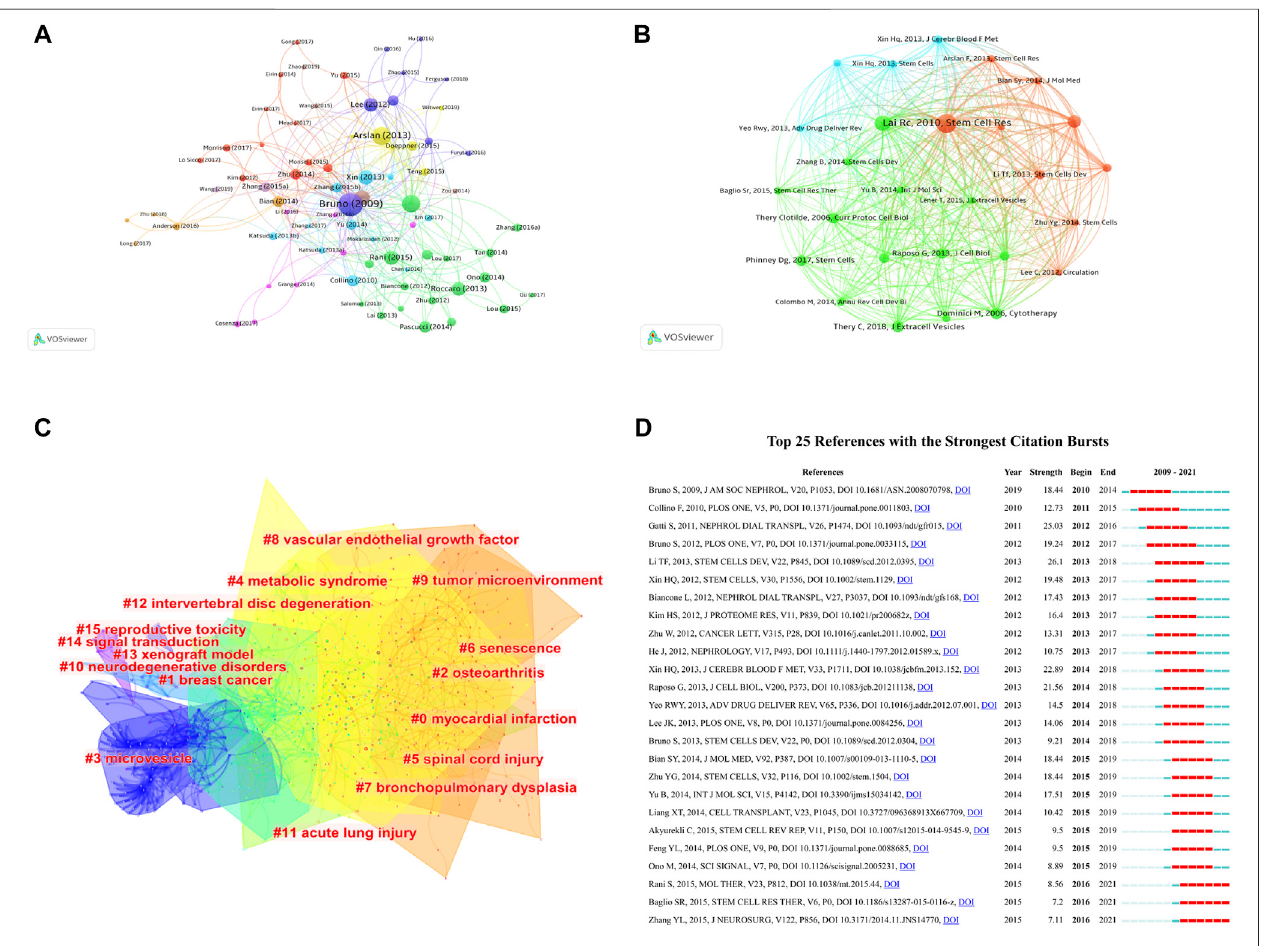
FIGURE 6 | Mapping of documents and references in studies on MSC-EVs. (A) Network map of citation analysis of documents with more than 150 citations. (B) Network map of co-citation analysis of references with more than 50 citations. (C) Clustering analysis of the co-citation network based on CiteSpace. (D) Top 25 references with strongest citation bursts based on